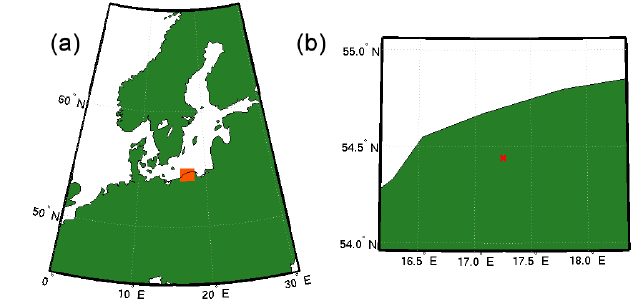
Figure 2. Location of the investigation area. (a) The red box marks the analysed gridded wind information from coastDat2 (1987– 2012). (b) The analysed area with the dune location (red x) close to Łeba,